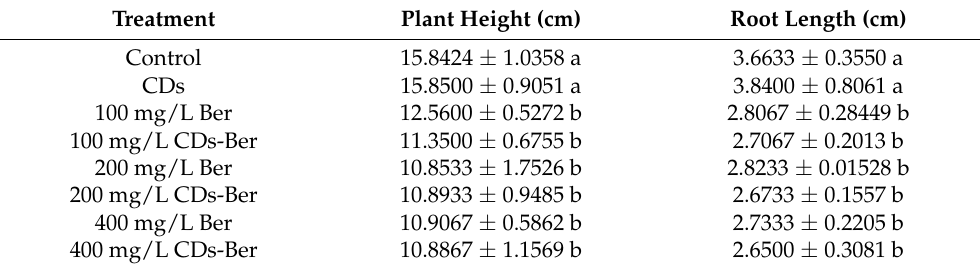
Table 2. Effects of hydroponic treatment with CDs, berberine, and CDs-Ber on plant height and root length of Echinochloa crus-galli (concentrations of berberine and CDs-Ber are 100, 200, and 400 mg/L; CK is deionized water).